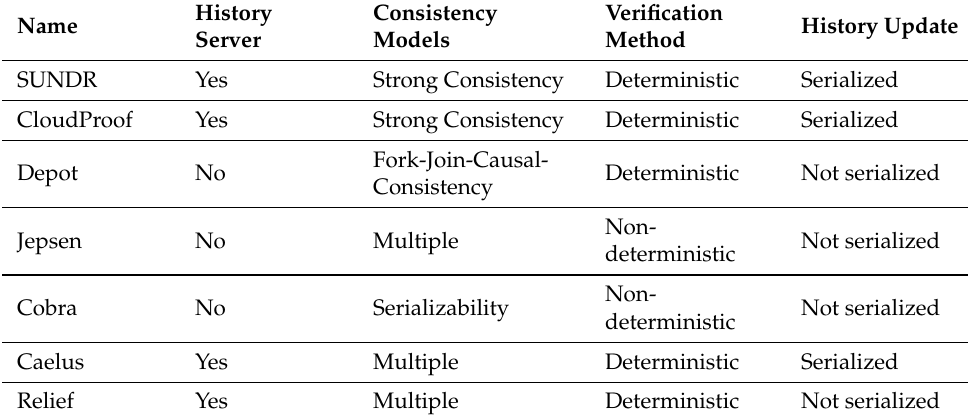
Table 2. CSS Architecture